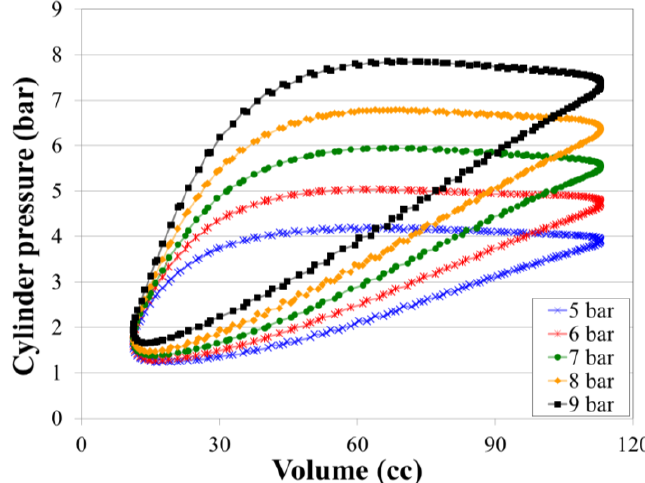
Figure 6. P-V diagram acquired during experiments at 1200 rpm and different supplied air pressures.